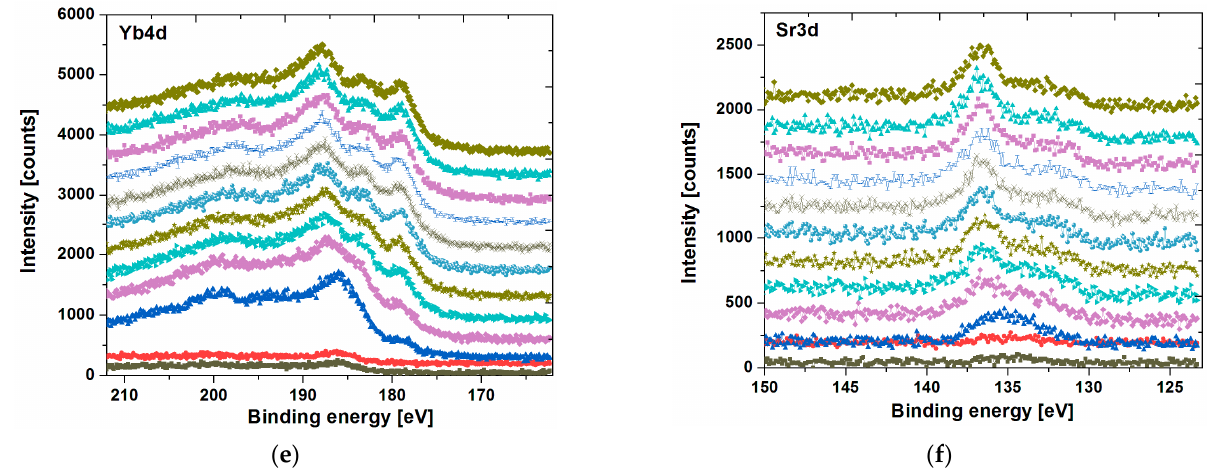
Figure 7. XPS core level lines of O1s ( a ), Mg2p ( b ), Zn2p ( c ), Ca2s ( d ), Yb4d ( e ), and Sr3d ( f ) of Mg 60 Zn 20 Ca 2.6 Yb 15.7 Sr 1.7 ingot after corrosion tests in Ringer’s solution at 37 °C.